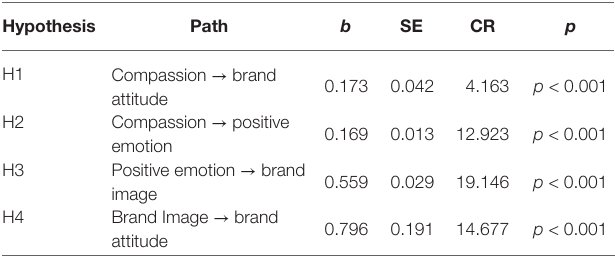
TABLE 4 | Path analysis